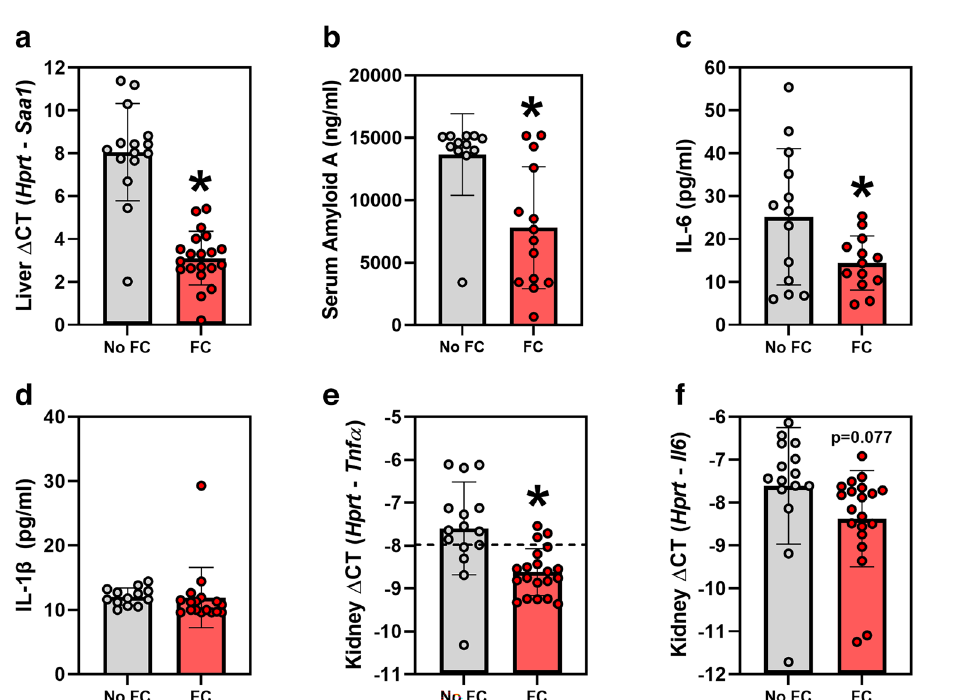
Figure 4. Markers of inflammation in Col4α3 knockout mice treated with or without 1% ferric citrate (FC) added to the diet. Parameters measured include: ( a ) liver Saa1 mRNA, ( b ) serum amyloid A, ( c ) serum interleukin 6, ( d ) serum interleukin 1β, ( e ) kidney Tnfα mRNA, and ( f ) kidney Il6 mRNA. In figure ( e ), the dotted line corresponds to quantitative real-time PCR cycle threshold values for blank samples. Data are presented as means and standard deviations. Two-tailed t-tests are used to compare groups, * p <